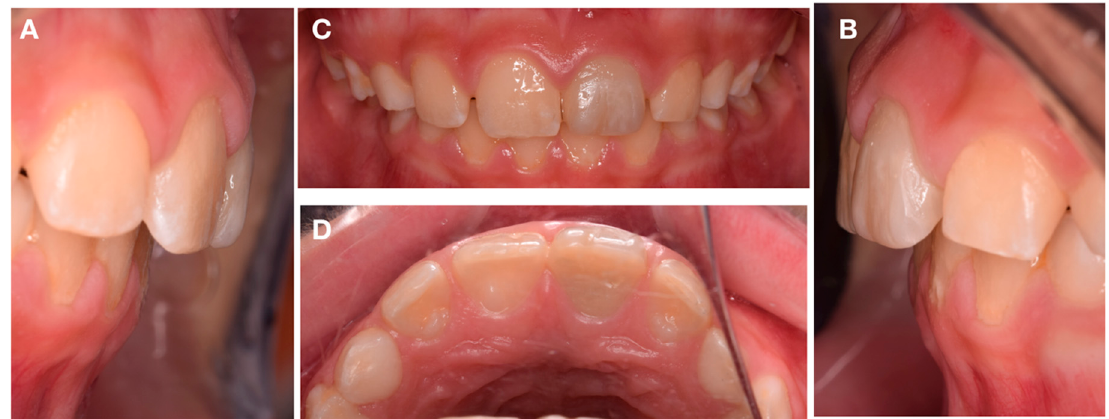
Figure 6. Intra-oral photography. Clinical aspect of the lateral ( A , B ), buccal ( C ), and palatal ( D ) view after the 4-year follow-up.